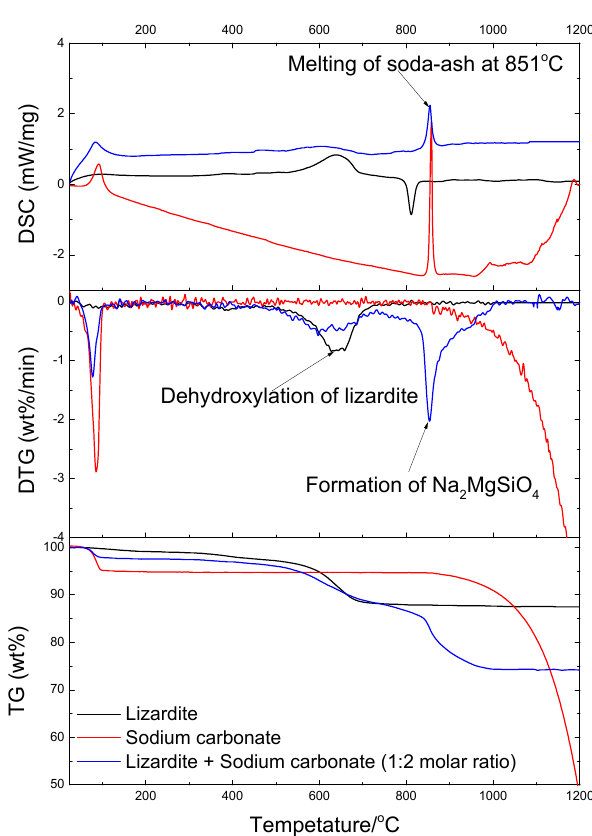
Figure 6. Thermogravimetric ‐ differential scanning calorimetry (TG ‐ DSC) curves of lizardite, sodium carbonate and the mixture of lizardite and sodium carbonate (argon atmosphere, 10 °C/min).